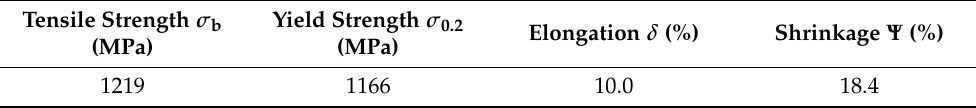
Table 2. Mechanical properties of Ti-17.